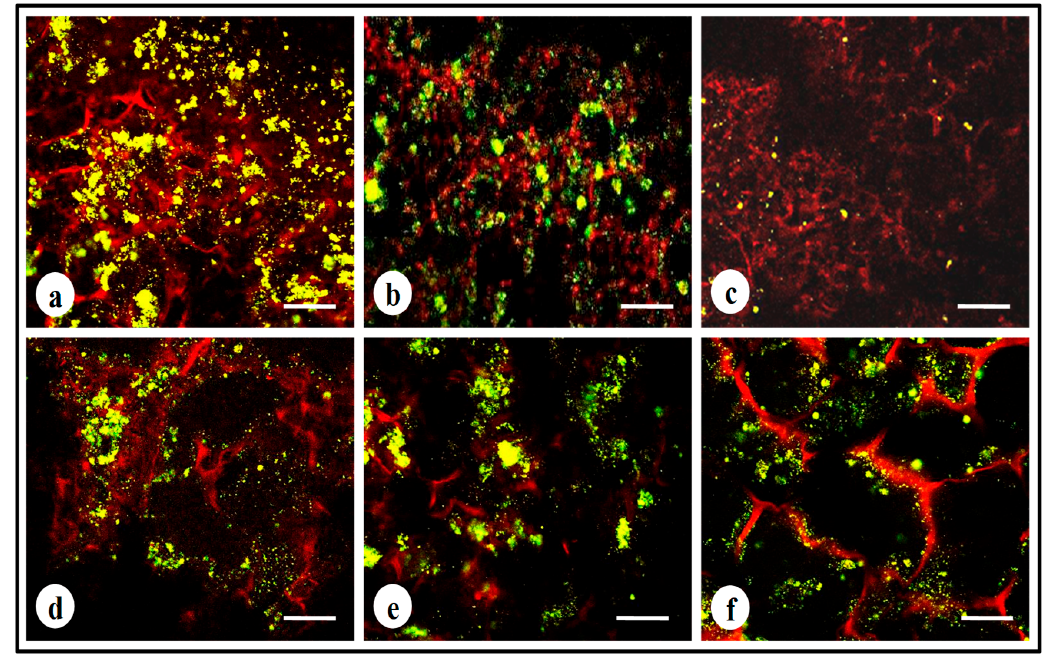
Figure 7. Live–dead stained confocal micrographs showing morphology of MDA ‐ MB ‐ 231 cells: a ) and d ) untreated MDA ‐ MB ‐ 231 cells, b ) doxorubicin treated cells (1 μ g/mL), c ) doxorubicin treated cells (100 μ g/mL), e and f ) cyclosaplin treated cells (1 and 100 μ g/mL). Scale bar = 200 μ m.